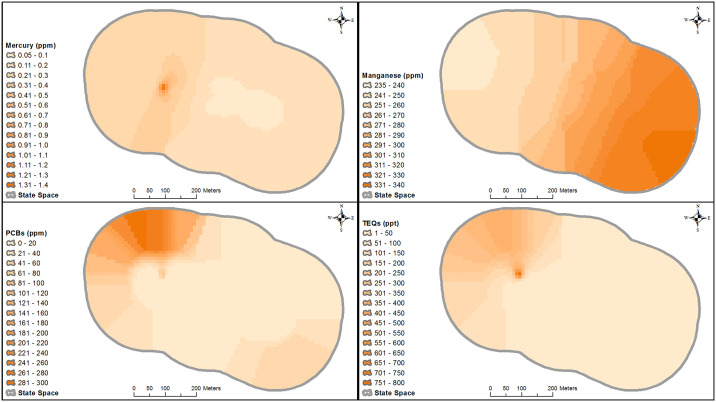
Spatial distributions of mercury, manganese, PCBs, and TEQs concentrations (ppm = parts per million, ppt = parts per trillion) in soil of Los Alamos Canyon, produced from interpolation using empirical Bayesian kriging models.Figure was created using ArcGIS 10.4.1.